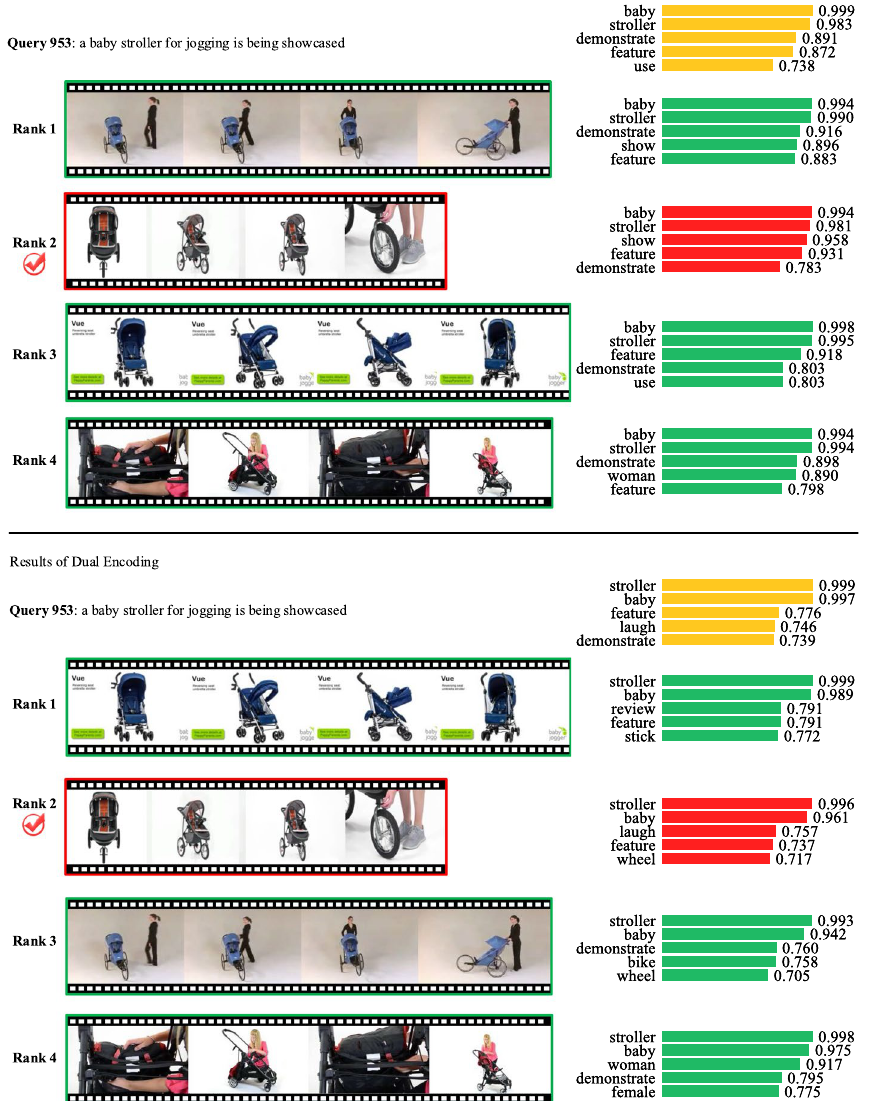
Fig. 5 The text-to-video retrieval results of our LADN method and Dual Encoding on the MSR-VTT B partition [18]. The top 4 ranked videos are shown for each query, where the ground truth is marked with a red box, and the others are marked with a green box. The last column is the predicted concepts corresponding to the second